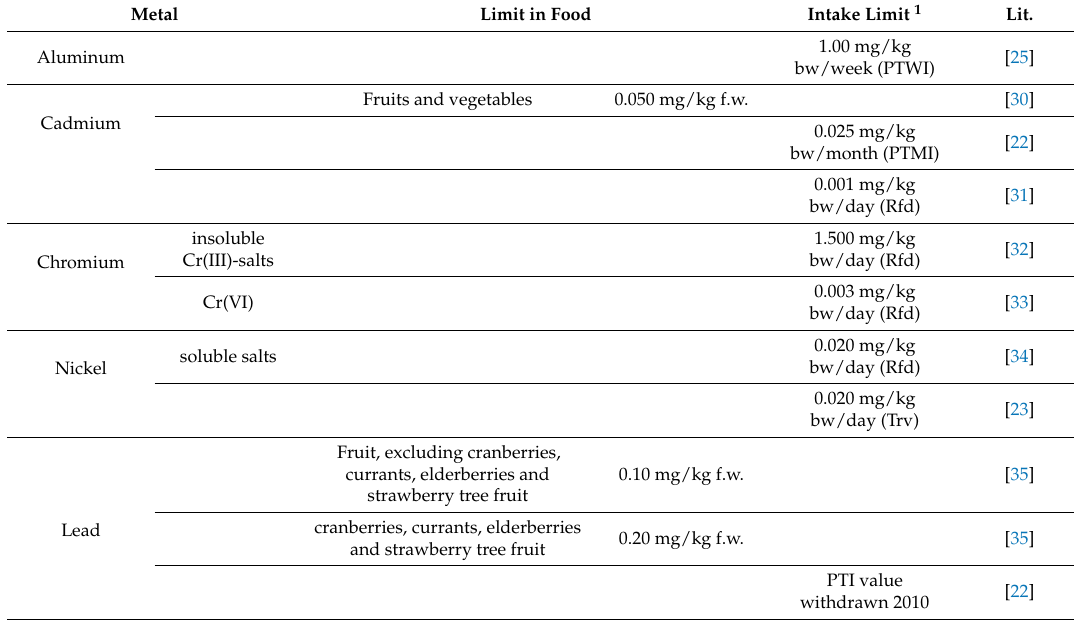
Table 4. Limits for metals in